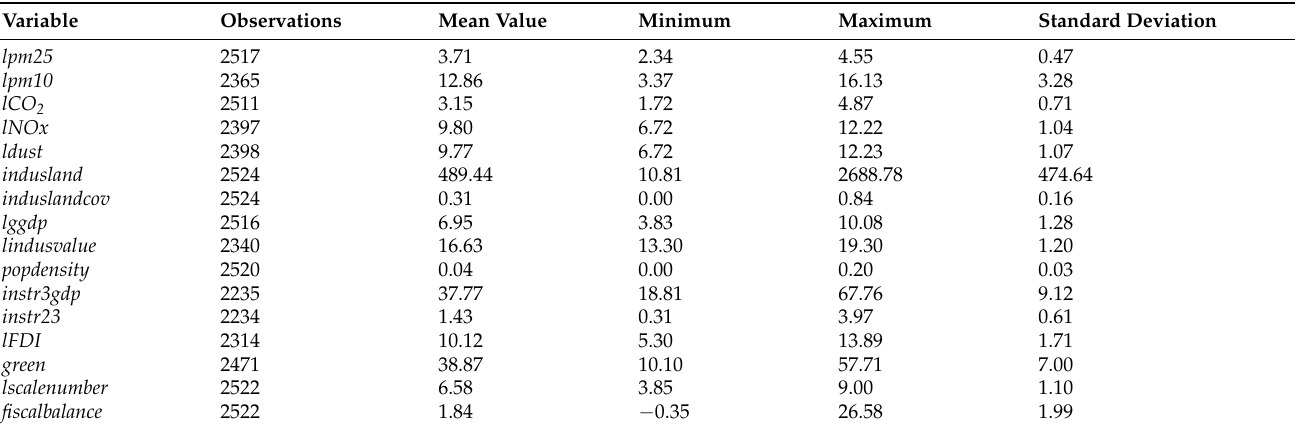
Table 2. Summary statistics for key